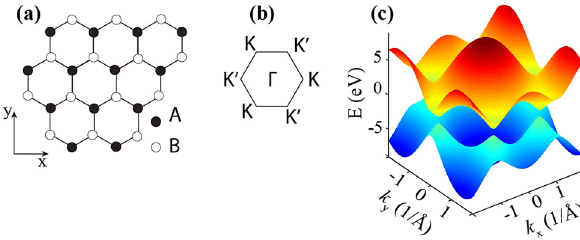
Figure 1: (a) Honeycomb crystal structure of graphene with sublattices A and B. (b) The first Brillouin zone of graphene with two valleys K and K ′ . (c) Energy dispersion a function of crystal wave vector for GG with the band gap of 1